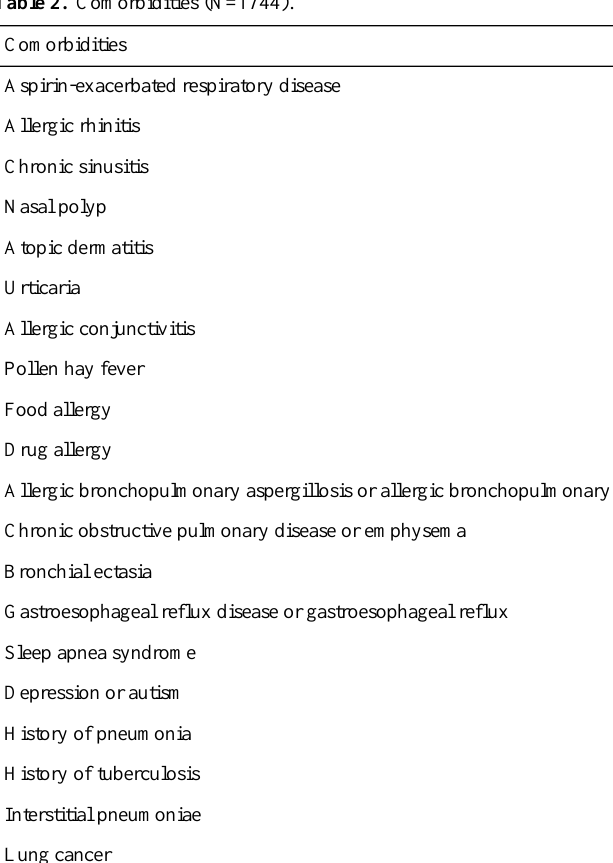
Table 2. Comorbidities